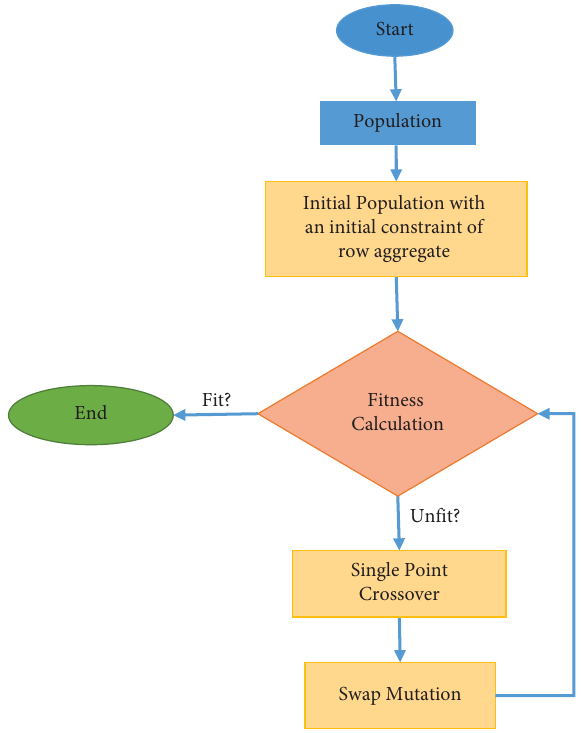
Figure 2: BISGA working